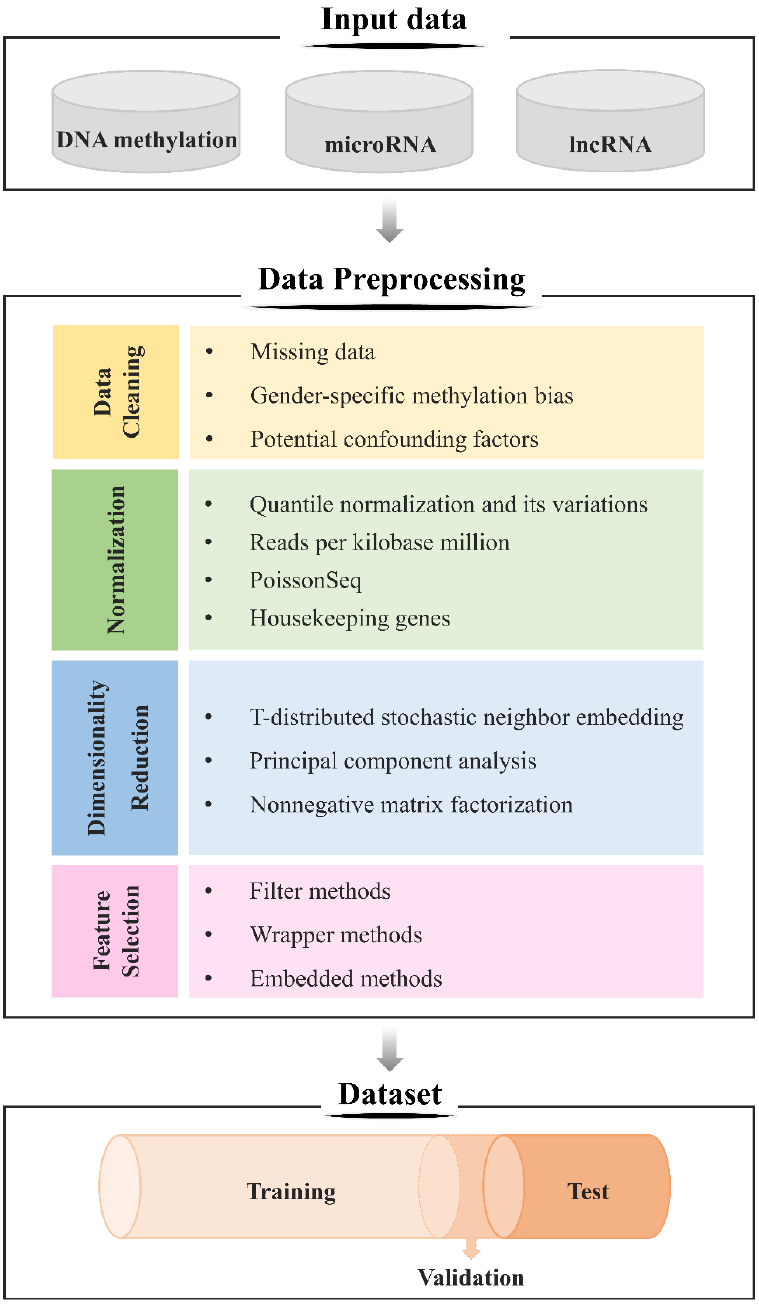
Figure 3. Data preprocessing flow for developing a predictive model in epigenomics.